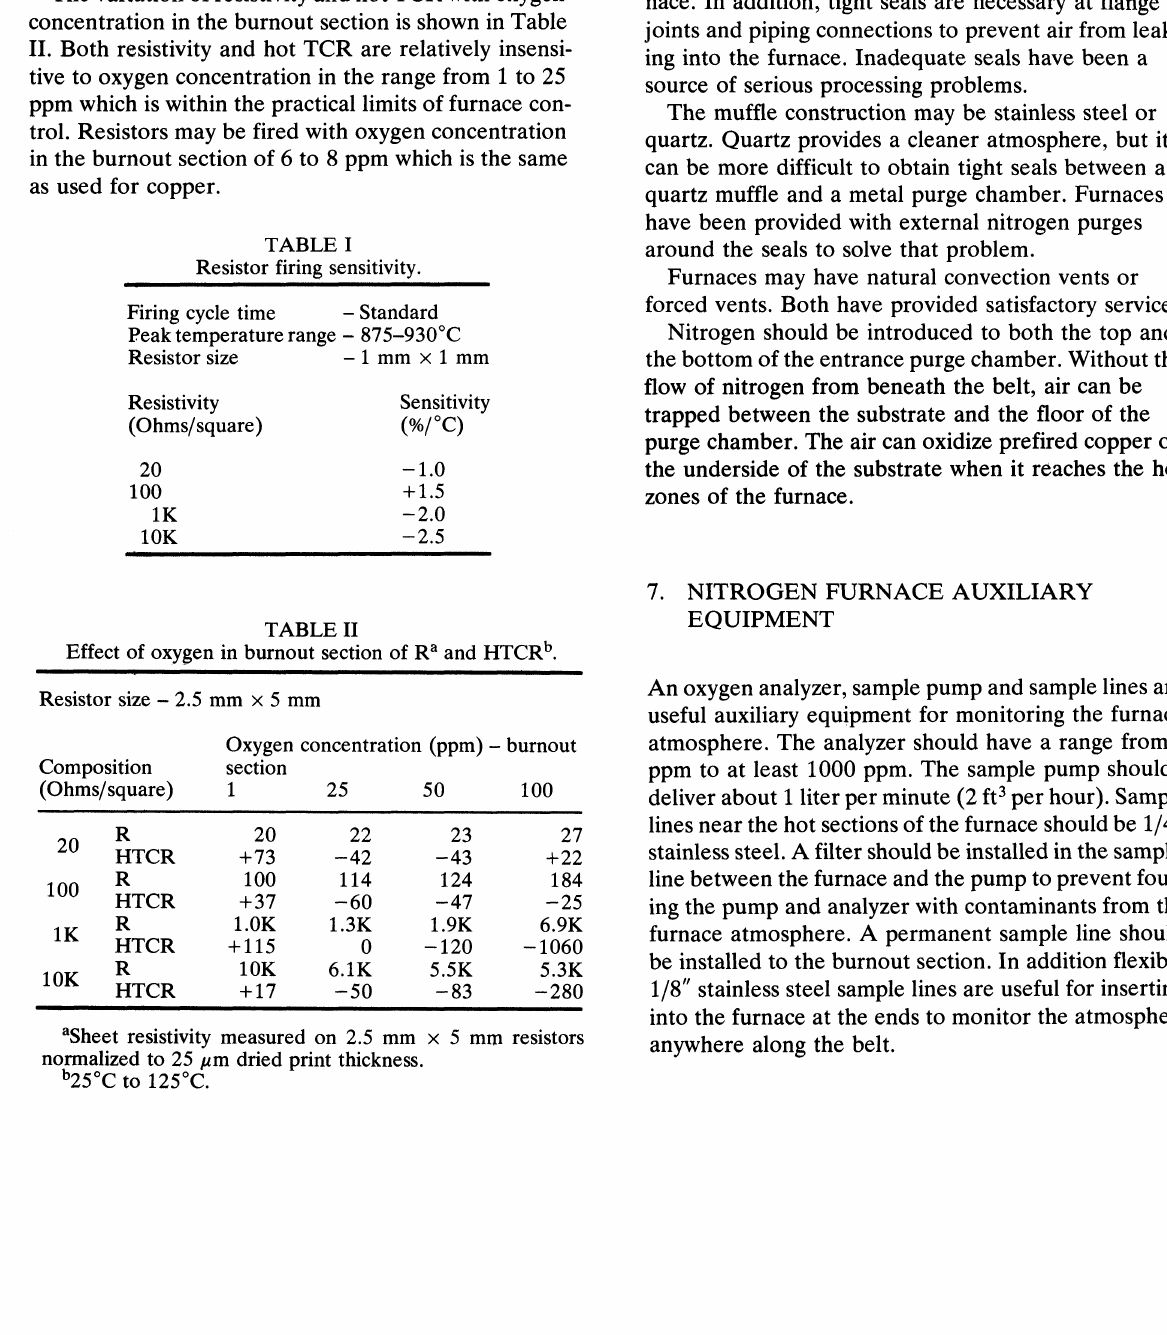
TABLE Resistor firing sensitivity.